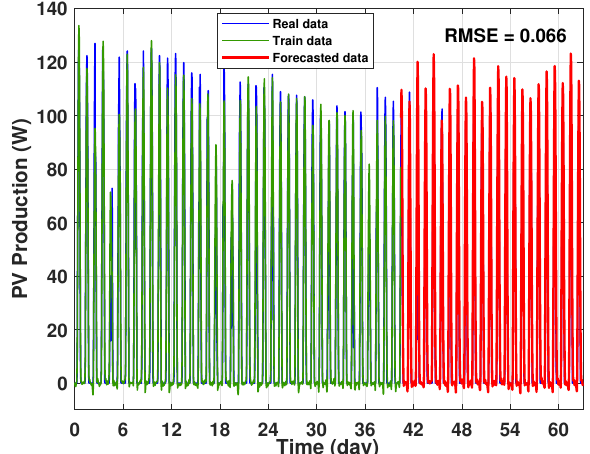
Figure 27. PV panel power forecasting over 25 days.